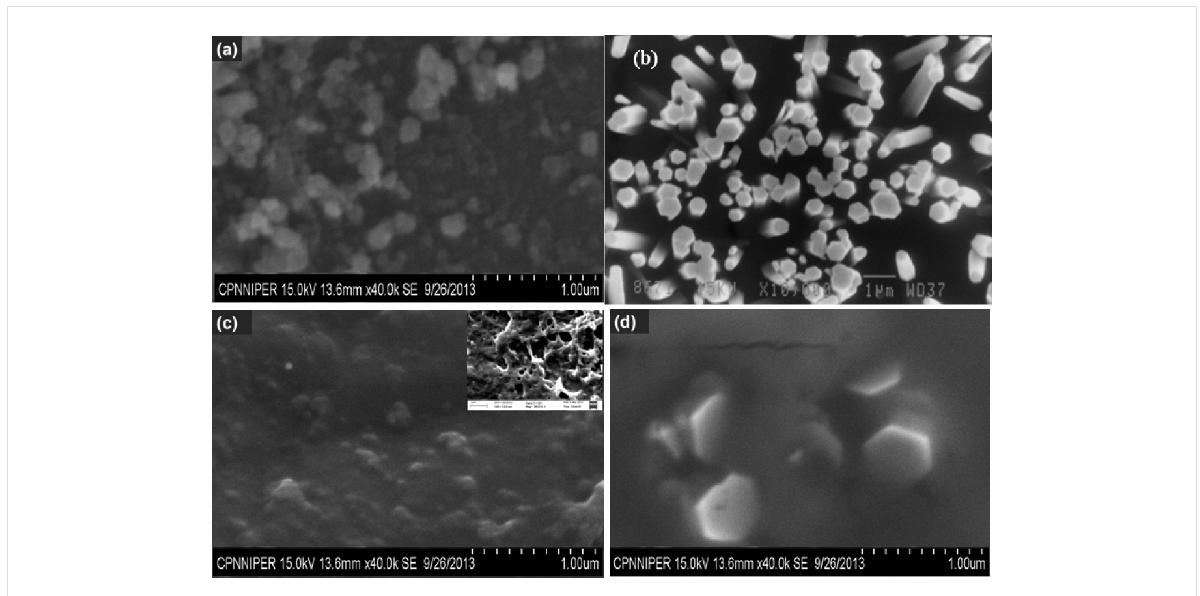
Figure 2: SEM characterization. (a) ZnO-TF has grown over the ITO substrate and was annealed at 400 °C. (b) ZnO-NR structure grown over the ZnO-TF seed layer. (c) ZnO-TF/bR hybrid structure prepared by drop casting. (d) ZnO-NR/bR hybrid structure.